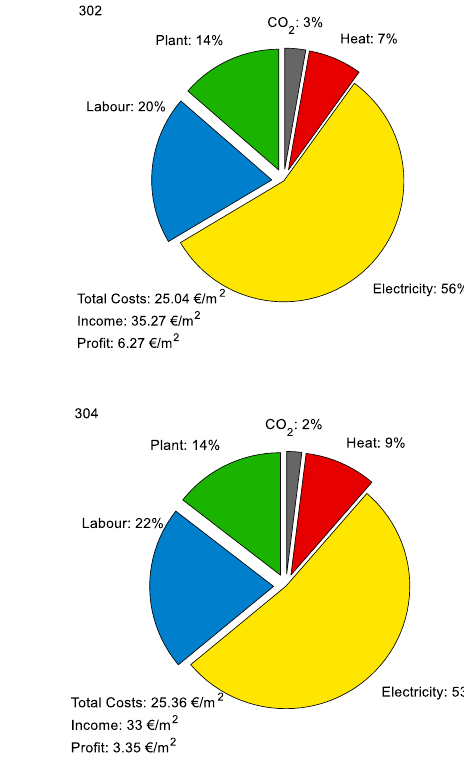
Figure A4. Net profit development (€/m 2 ) realized by different teams in different greenhouse compartments (301-306) during the harvesting period (13 February until 29 May 2020) and total net profit (€/m 2 ).